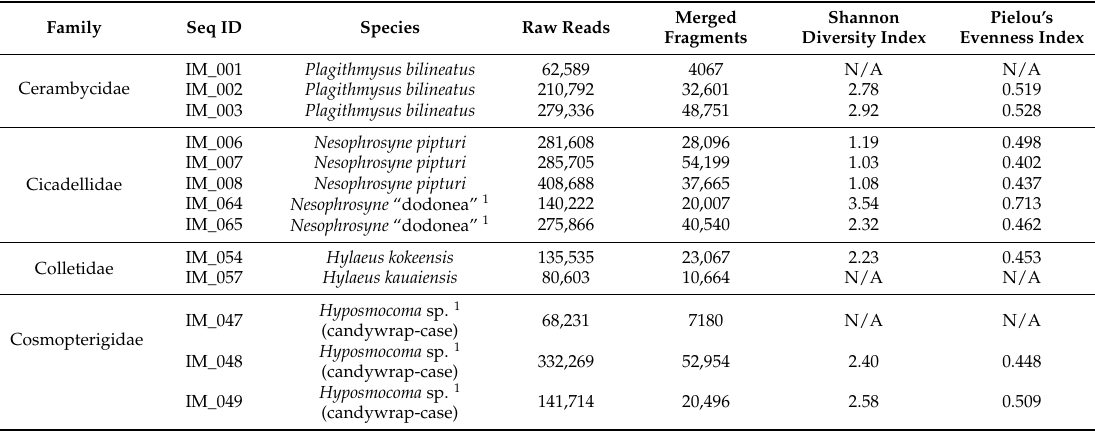
Table 2. Bacterial 16S barcoding sequencing depth and